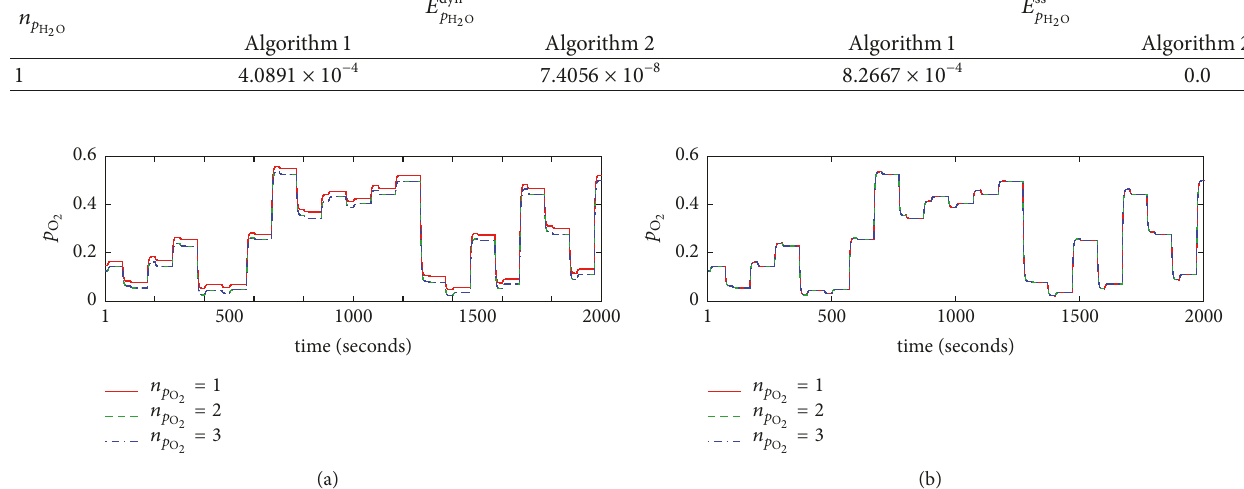
= 1, 2 )andfullorder( 𝑛 = 3 )modelsdeterminedbyalgorithm 𝑝 O 2 O 2